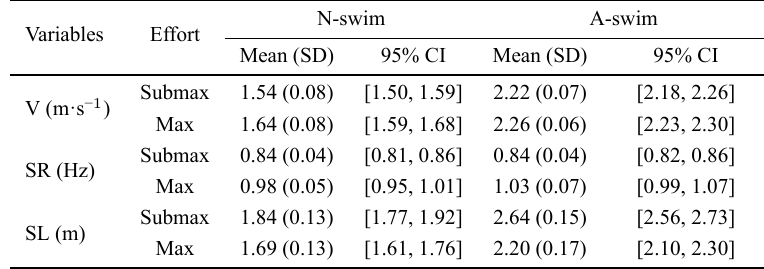
V, swimming velocity; SR, stroke rate; SL, stroke length; Submax, submaximal effort; Max, maximal effort; N-swim, swimming without towing device; A-swim, swimming with towing device; 95% CI, 95% confidence